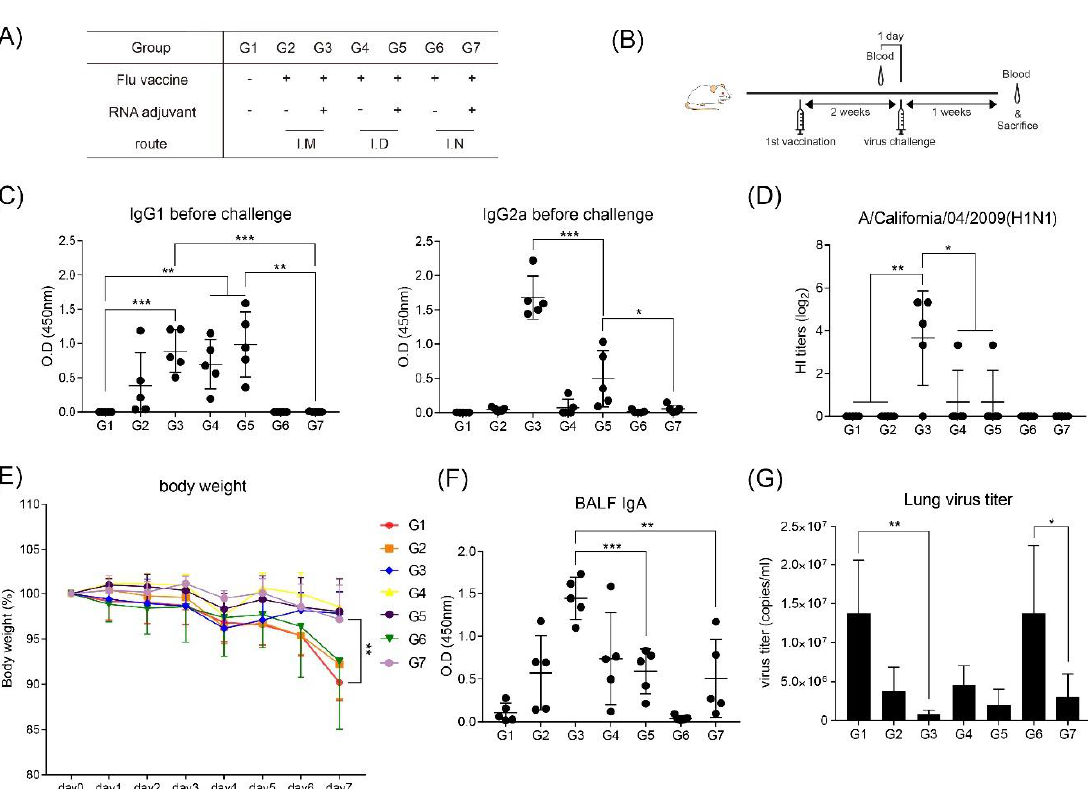
Figure 6. Induction of influenza-specific IFN- γ releasing cells. The population of influenza -vaccine- specific cells secreting IFN- γ w as quantified by ELISPOT assay. *, p < 0.05; **, p < 0.005. 4. Discussion and Conclusions Because MERS-CoV does not have a commercially licensed vaccine, studies to develop the vaccine are still active [24]. In the case of influenza, the vaccine is present, but the inactivated vaccine is less effective than the attenuated vaccine [25]. Generally, protein-based and/or inactivated vaccines